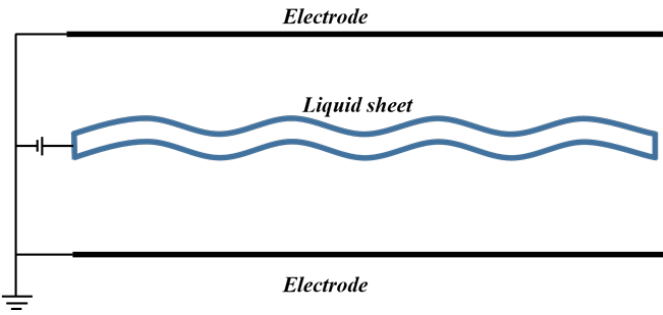
Figure 1. Schematic diagram of moving liquid sheet in an electric field.